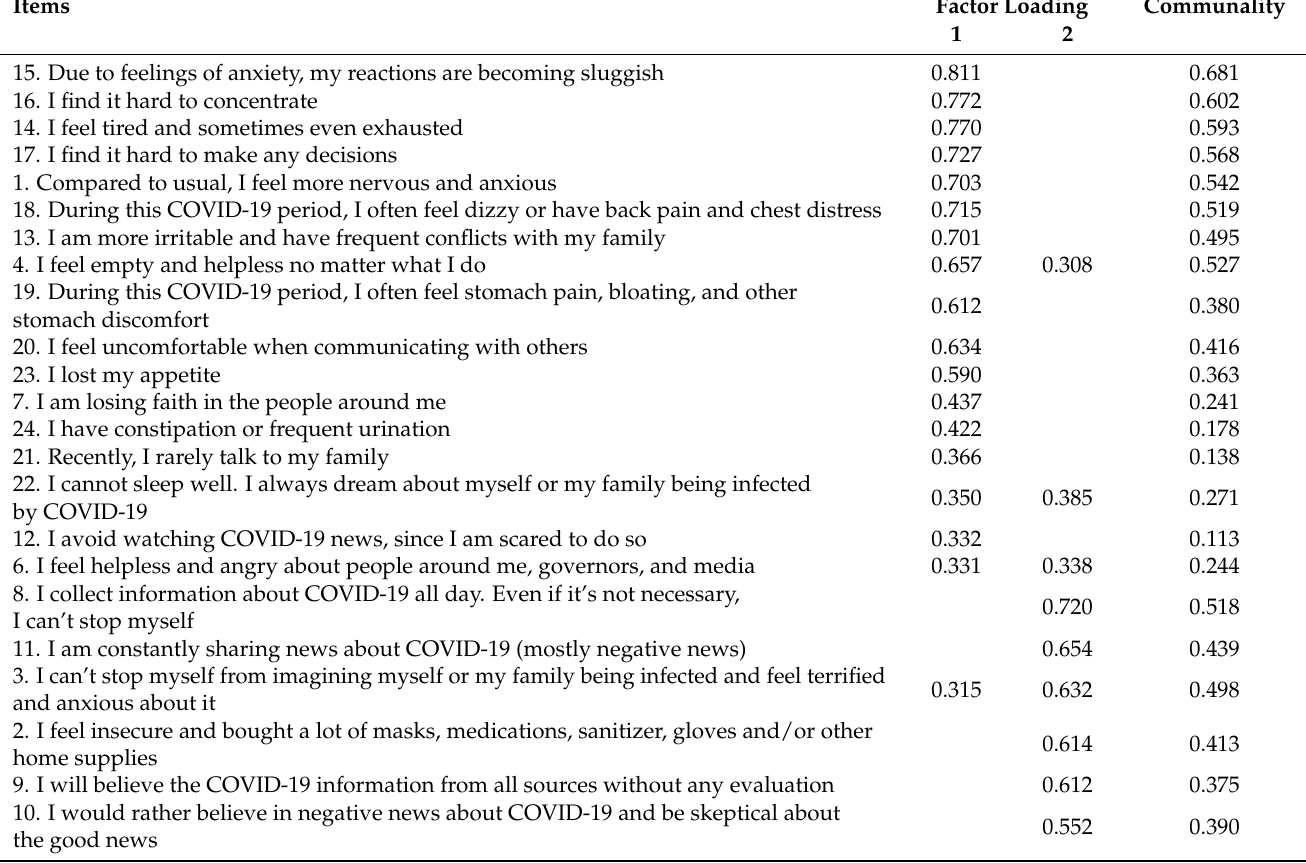
Table 3. Factor loadings for the rotated